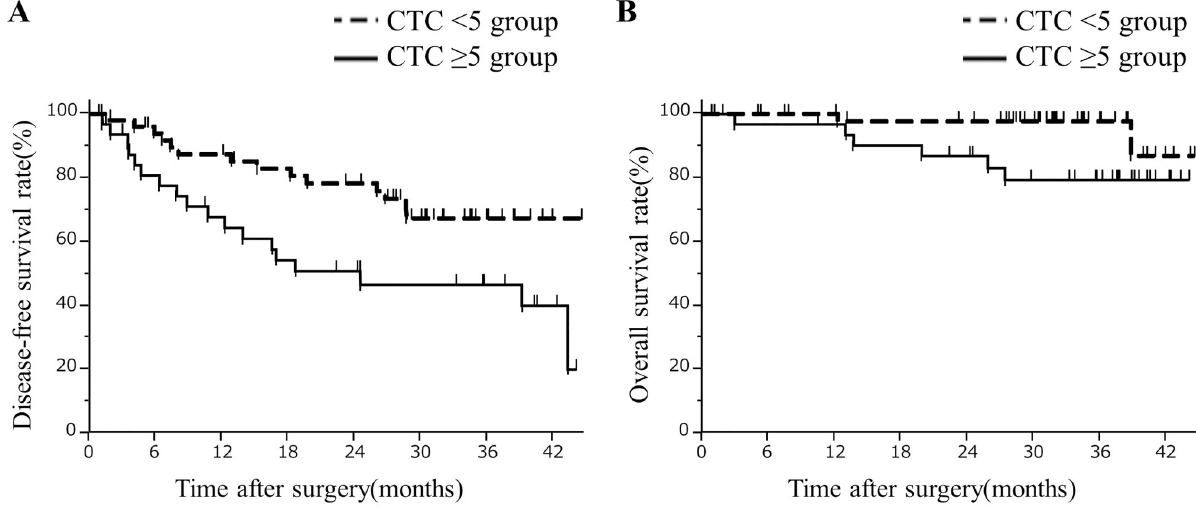
Fig 6. (A) Comparison of disease-free survival rates after hepatectomy of the CTC � 5 group to that of the CTC < 5 group . The disease-free survival rates were significantly lower in the CTC � 5 group than the CTC < 5 group (log-rank test; p = 0.015). (B) Comparison of overall survival rates after hepatectomy of the CTC � 5 group to that of the CTC < 5 group . The overall survival rates were significantly lower in the CTC � 5 group than the CTC < 5 group (log-rank test; p =